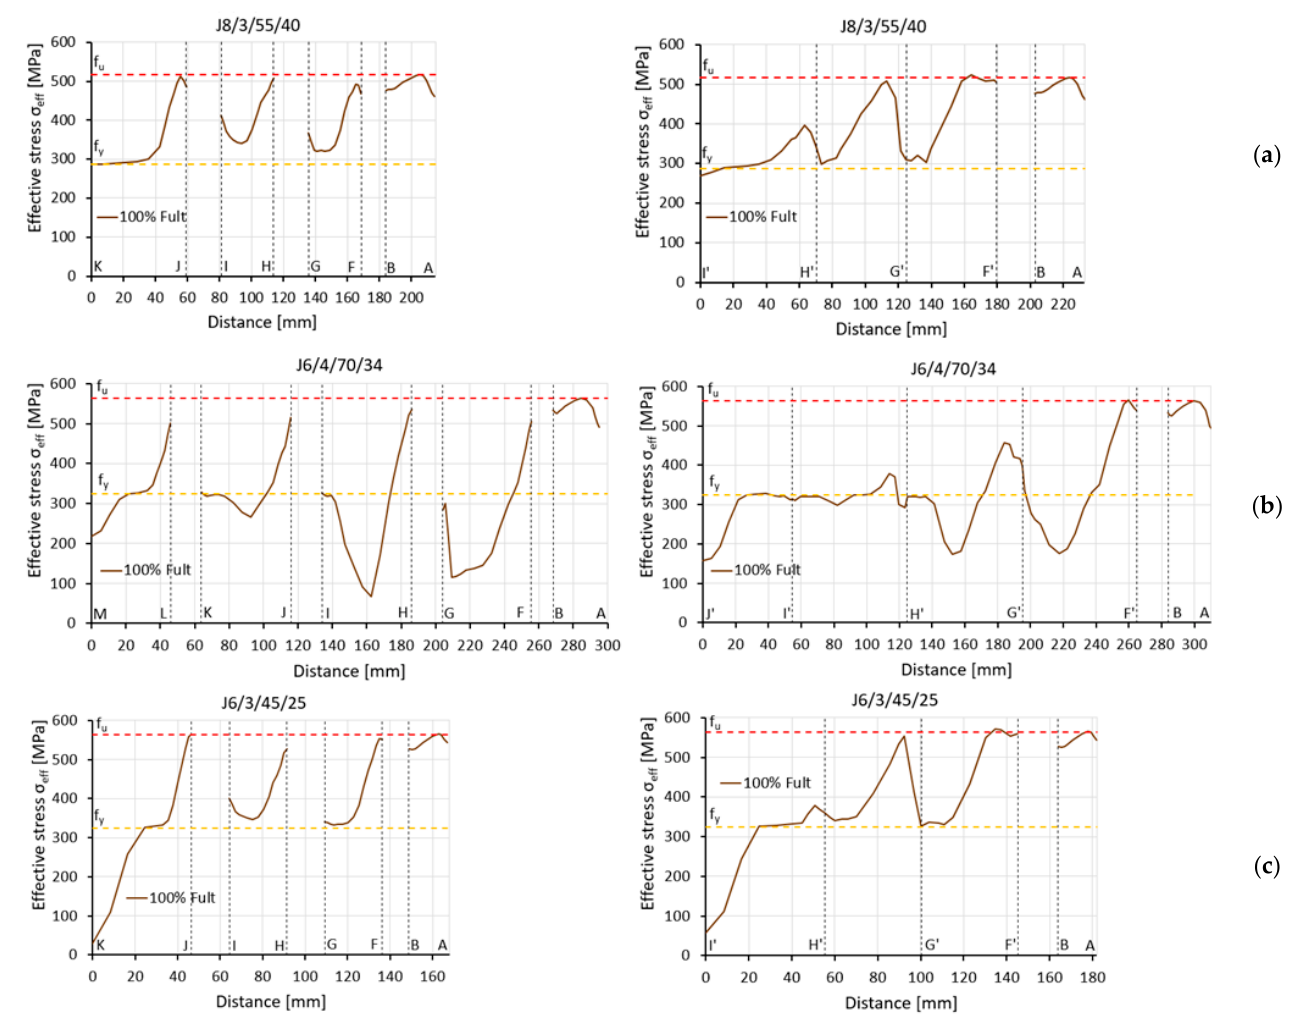
Figure 15. Effective stress distribution in block tearing sections for: ( a ) block tearing, ( b ) net section tearing, ( c ) limited block tearing (left diagrams for net cross section A nv , right diagrams for gross cross section A gv ).